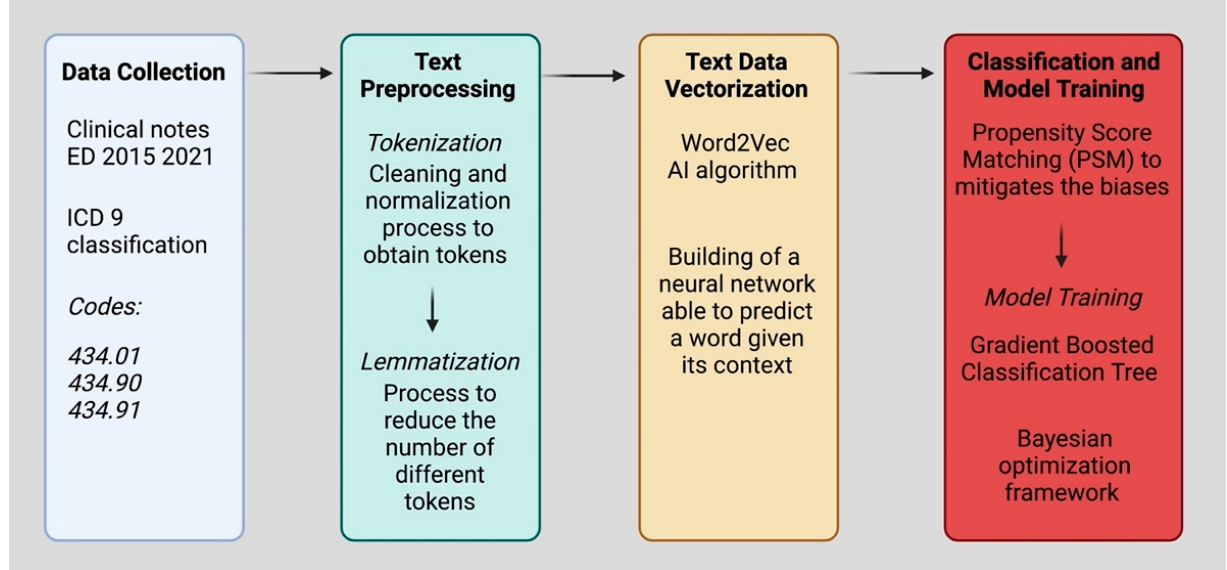
Figure 1. Word2vec embedding model.